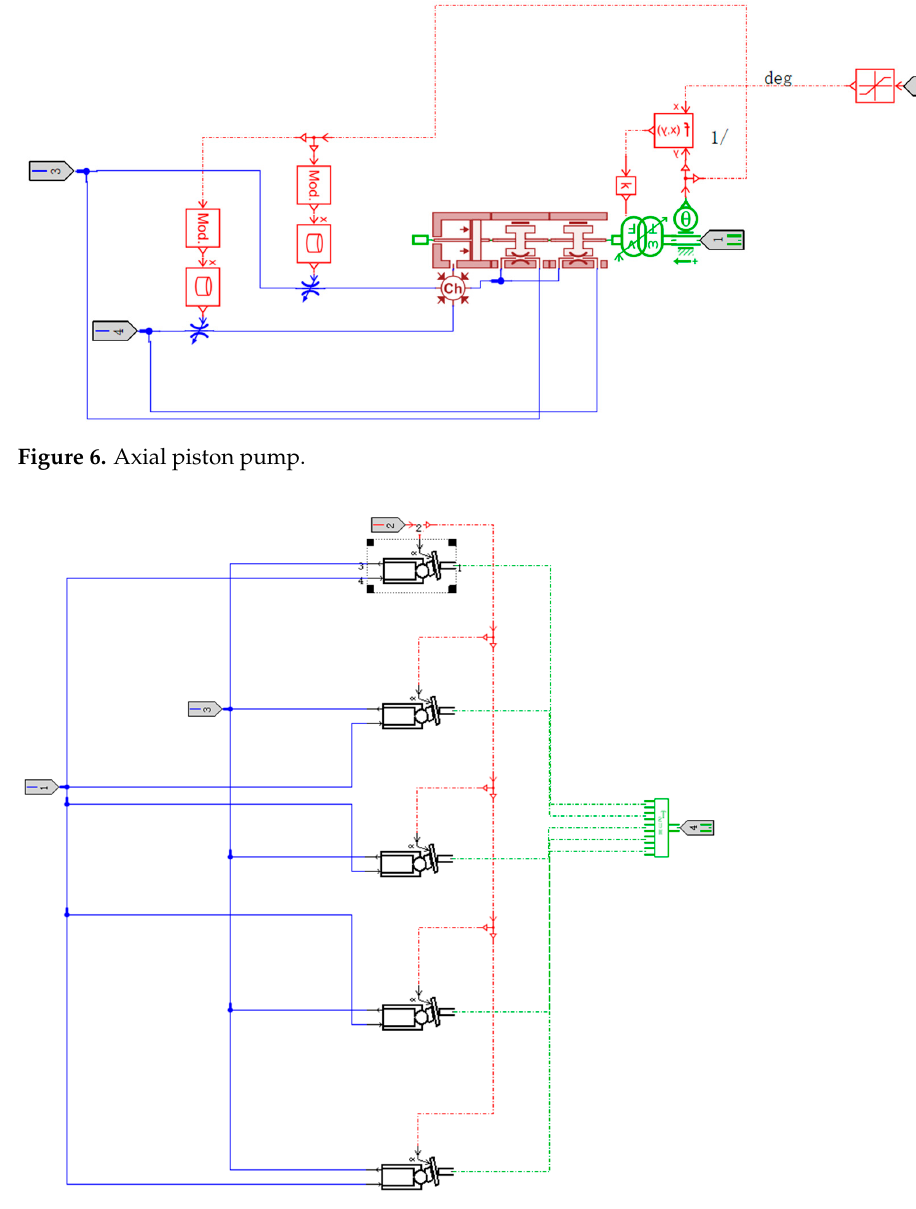
Figure 7. Single piston pump model.